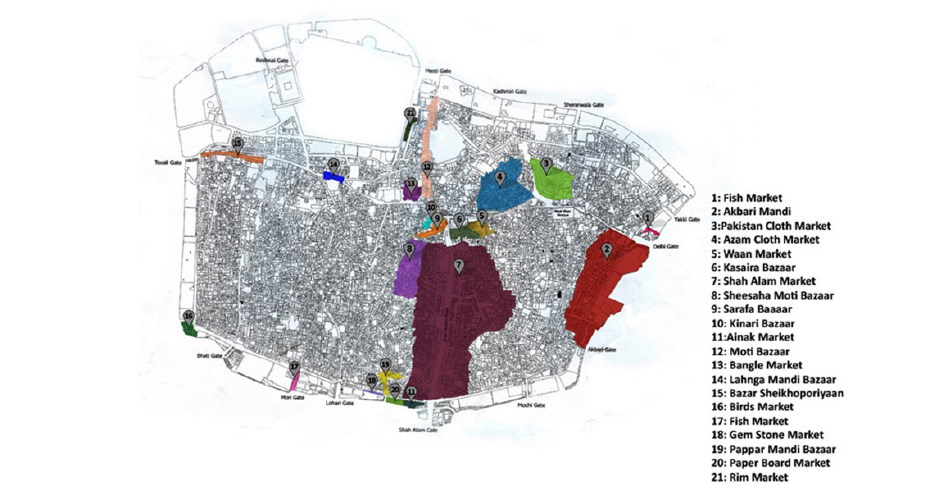
Figure 3. Main Bazaar streets of the Walled City of Lahore (source: Walled City of Lahore Authorities,